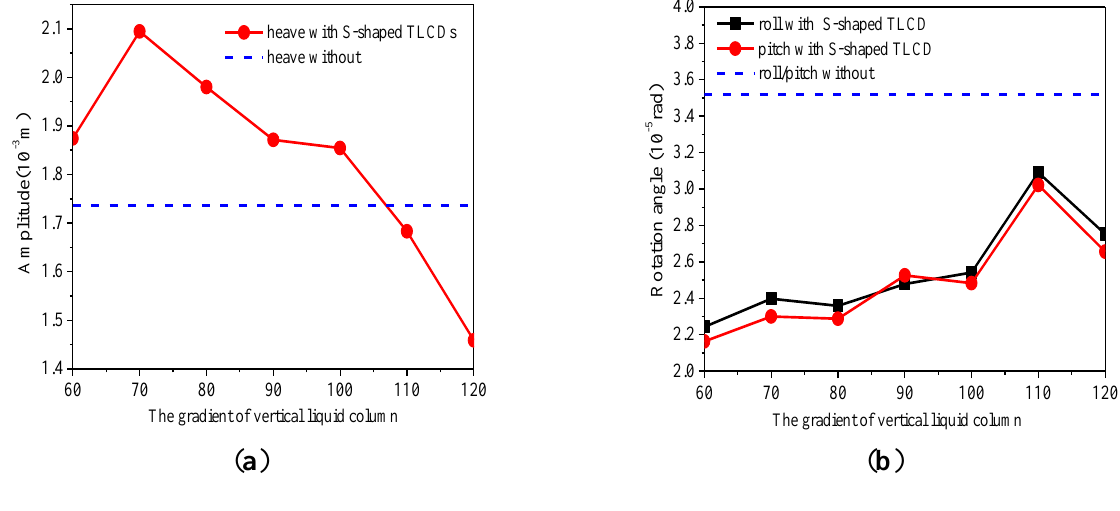
Figure 8. Comparison of responses for x 3 for ( a ) surge, sway; ( b ) heave; ( c ) roll, pitch.